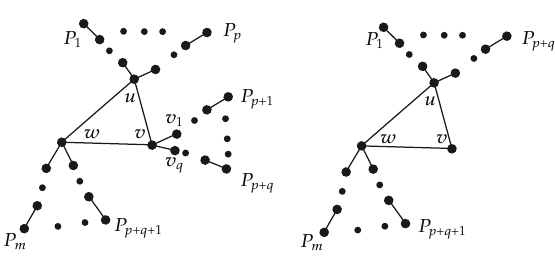
Figure 4: Example of π 4